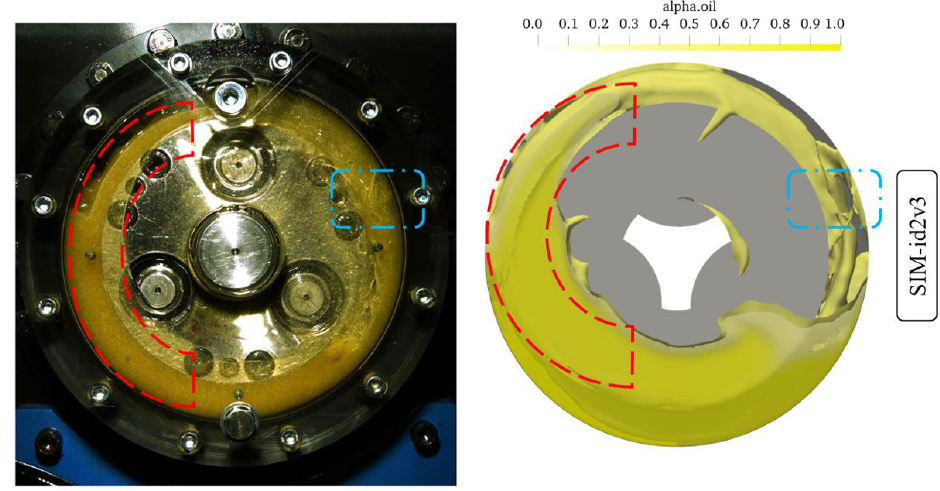
Figure 11. Experimental ( left ) and CFD ( right ) comparison of the oil flow for SIM-id2v3.